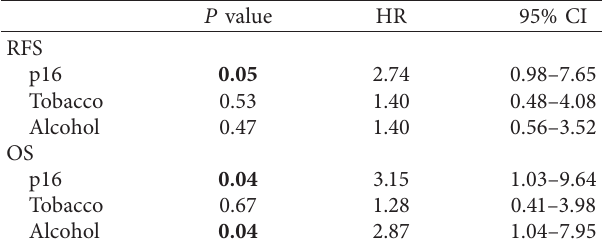
Figure 2: Survival and tobacco or alcohol habits in OSCC patients. (a) The prognosis for non- and light smokers (no tobacco, n � 28) significantly better than for moderate and high smokers (tobacco, n � 101) regarding to RFS (HR: 2.7, 95% CI:1.1–6.5) and OS (HR: 3.6, 95% CI: 1.4–9.2). (b) The survivals for non- and light drinkers (no alcohol, n � 37) significantly longer than for moderate and high drinkers (alcohol, n � 92) regarding to RFS (HR: 2.7, 95% CI: 1.3–5.7) and OS (HR: 4.7, 95% CI: Table 2: Multivariate analysis evaluating the correlation between p16 positivity in tumor, tobacco and alcohol consumption, and patient survivals (RFS and OS).